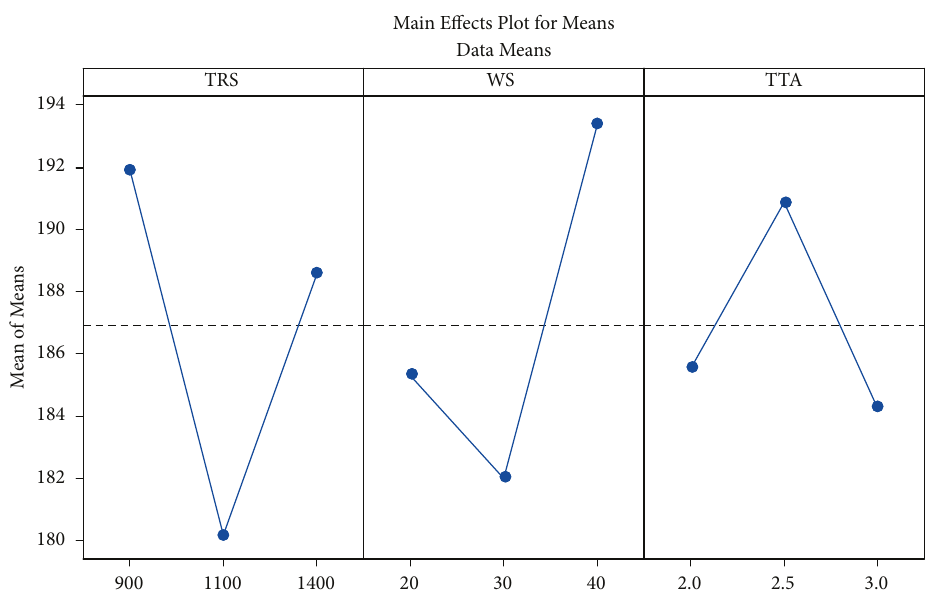
Figure 13: Tensile strength means plot. Table 8: Analysis of variance response (TS).